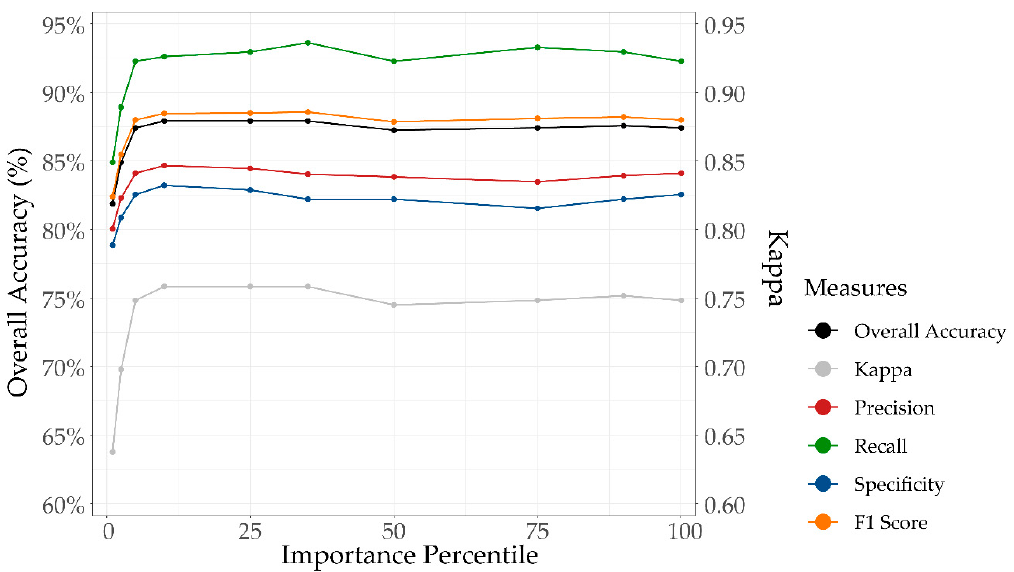
Figure 10. Model comparison when incorporating feature selection using multiple classification assessment metrics. assessment